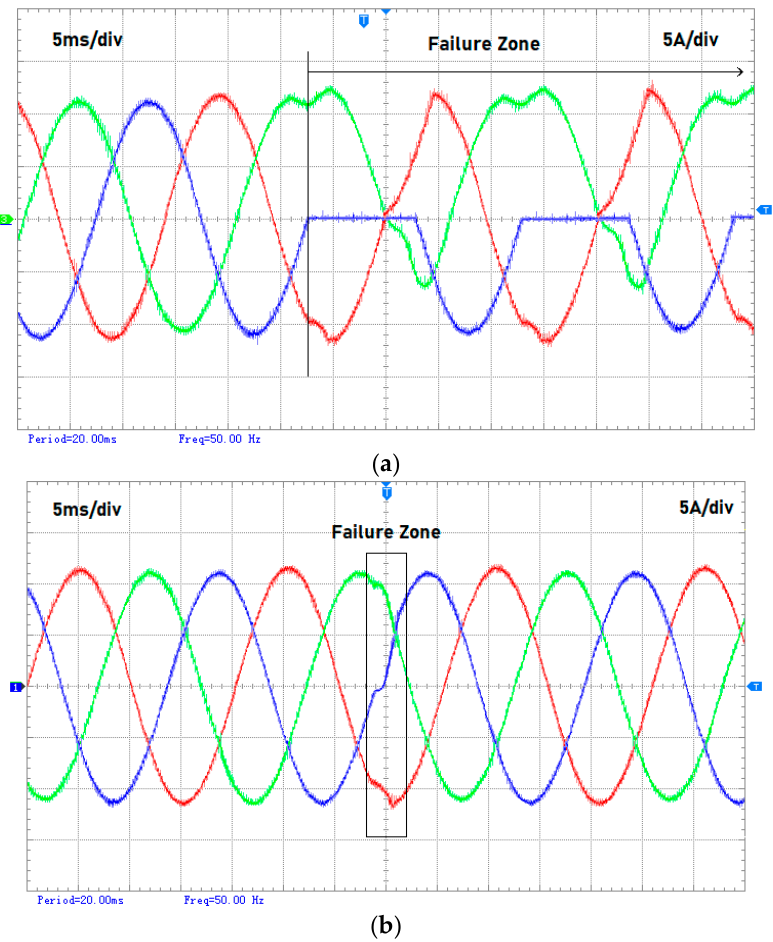
Figure 5. Experimental inverter three-phase currents: ( a ) for a permanent fault in transistor T 1U ; ( b ) for an intermittent fault in transistor T 1 U .